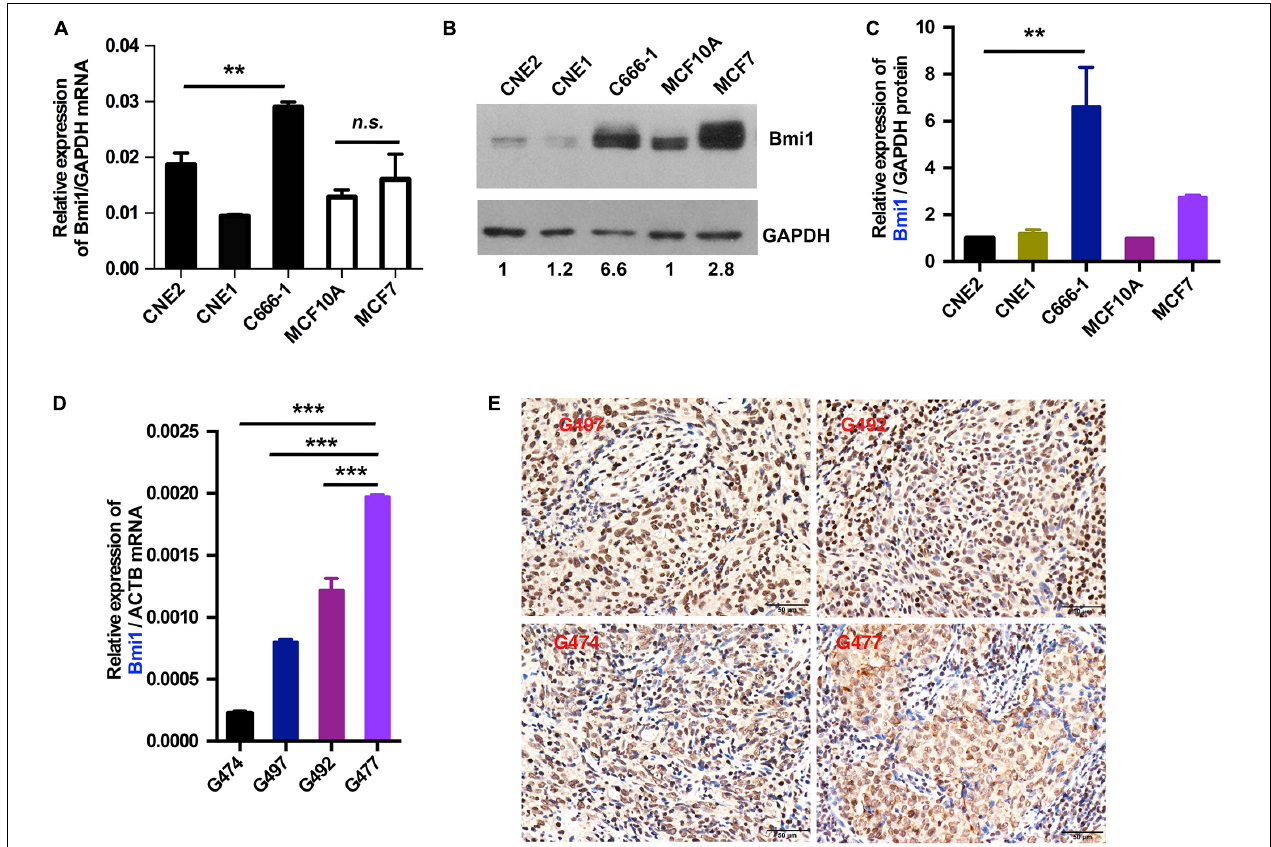
FIGURE 1 | The mRNA and protein levels of Bmi1 are inconsistent in nasopharyngeal carcinoma, breast cancer cell lines, and nasopharyngeal carcinoma tissues. (A,B) The protein and mRNA levels of Bmi1 were analyzed by qRT-PCR (A) and Western blot (B) in CNE2, C666-1, MCF10A, and MCF7 cell lines. GAPDH was used as internal control. (C) The intensity of the bands was determined with ImageJ software. (D,E) The mRNA and protein levels of Bmi1 were analyzed by qRT-PCR (D) and immunohistochemistry staining (E) in nasopharyngeal carcinoma tissues. ACTB was used as qPCR internal control. A representative result of three independent experiments is shown ( n = 3). The graphs show the mean ± SEM. ** P < 0.01, *** P < 0.001; Student’s t